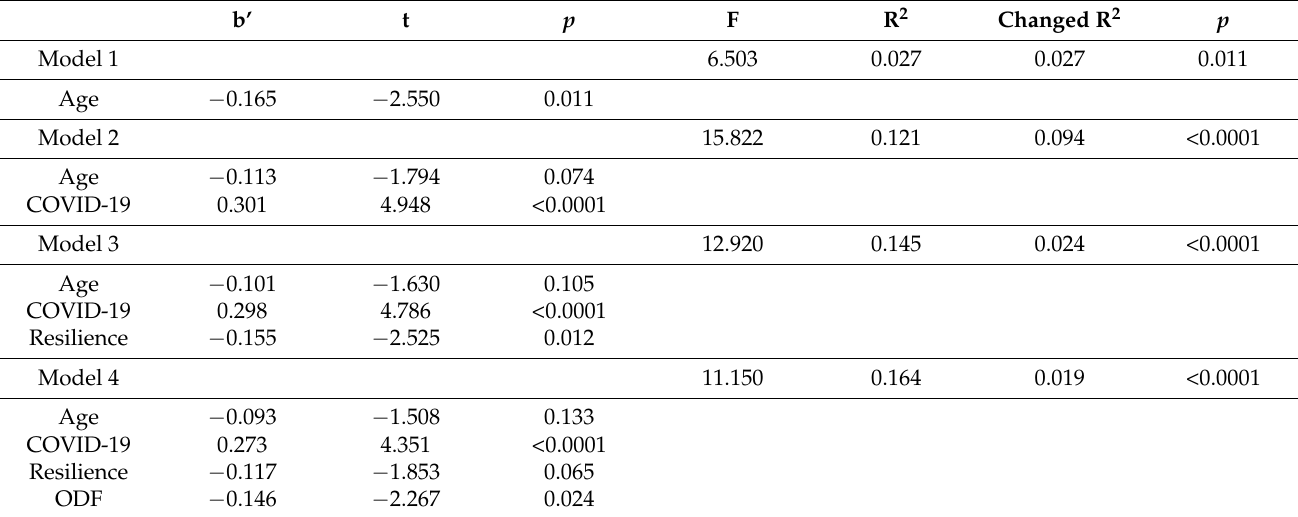
Table 5. Hierarchical regression analysis of predictors of emotional exhaustion ( N = 233).